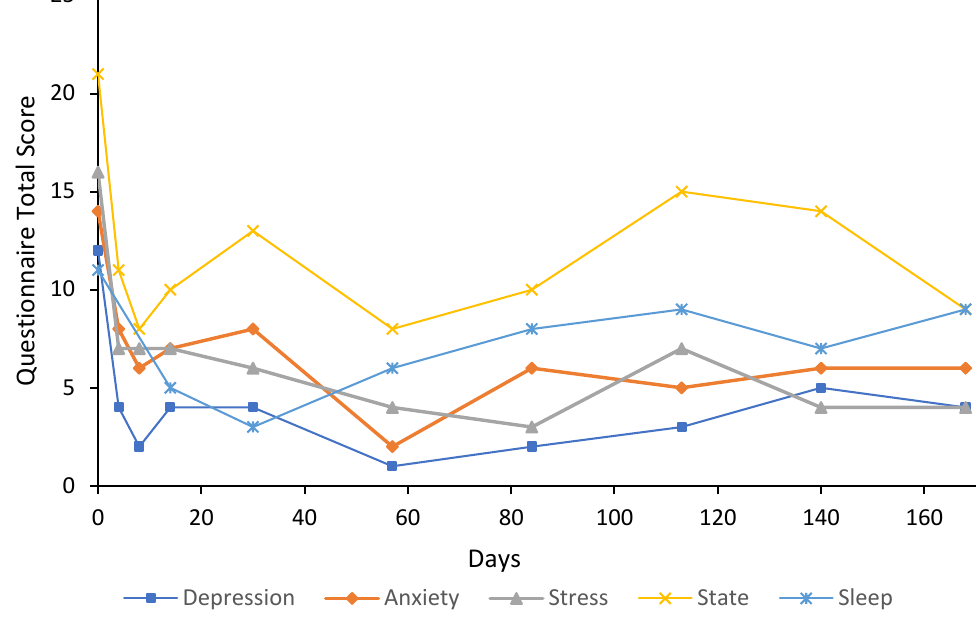
Figure 1. Line graph showing Case 1 results from the DASS-21 (depression, anxiety, and stress subscales), SSAI-6, and JSS at each follow-up. The participant was treated with an eight-day flumazenil infusion without re-treatment during the follow-up period.